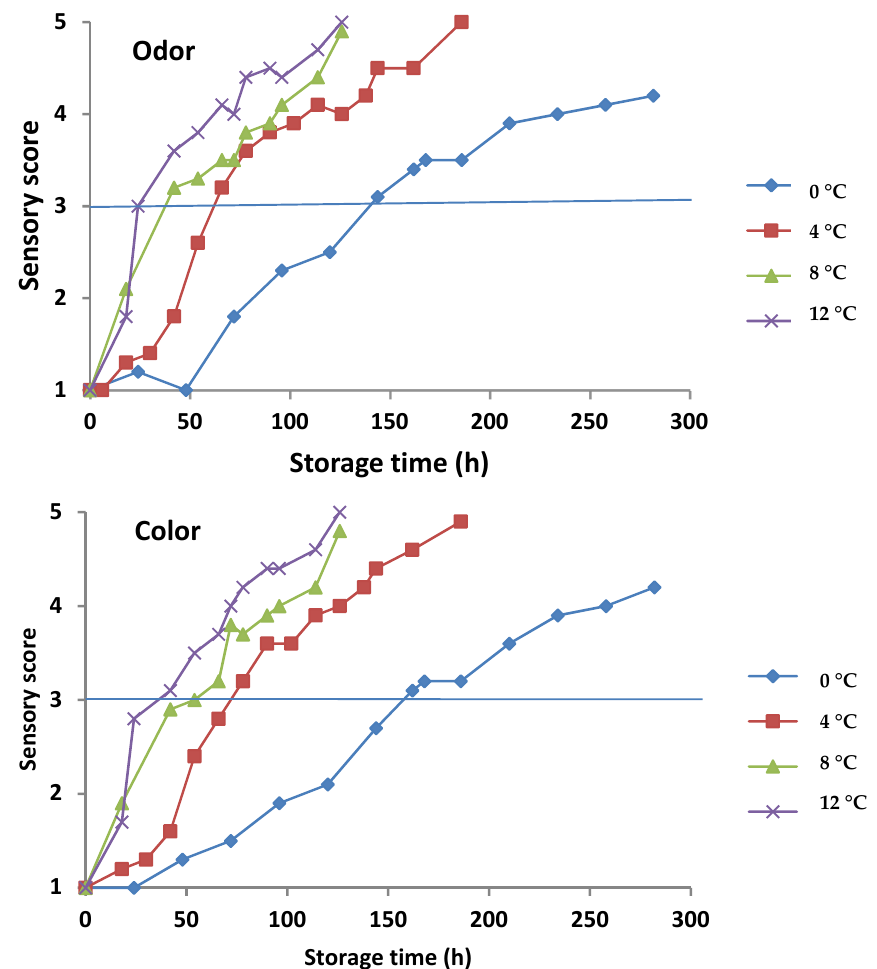
Figure 2. Sensory scores of gilthead sea bream fillets for odor and skin color attributes stored under aerobic conditions. Solid line indicates the threshold value for sample rejection.